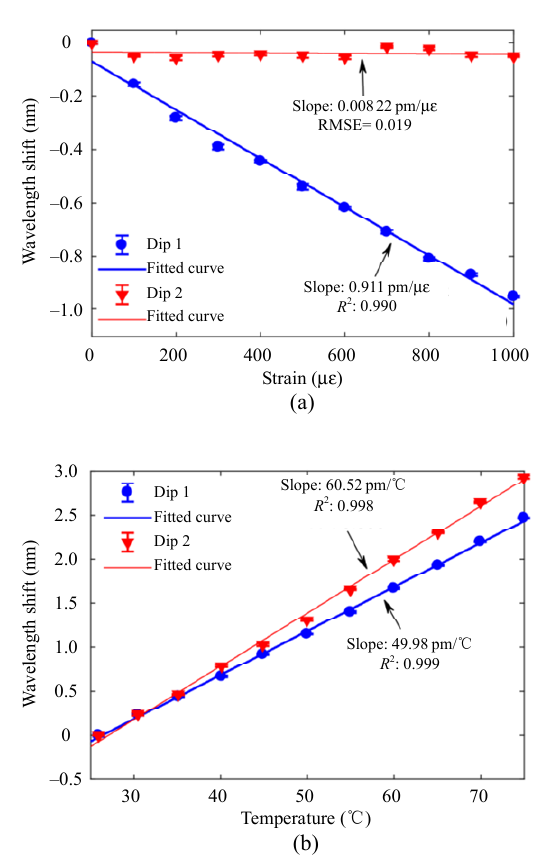
Fig. 7 Average wavelength shift versus (a) strain and (b) temperature for all